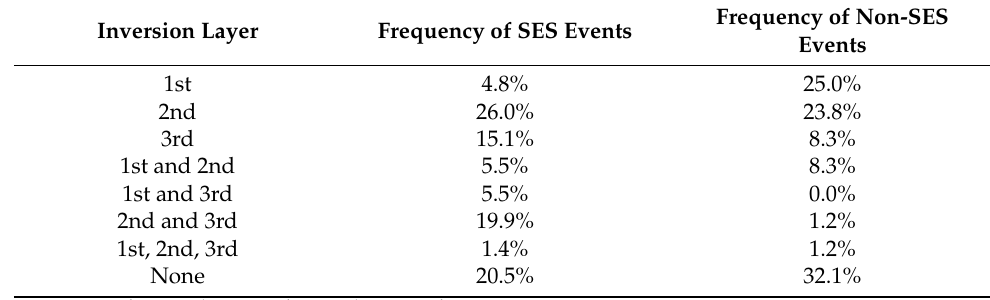
Table 4. Presence and location of inversion layers in SES and non-SES